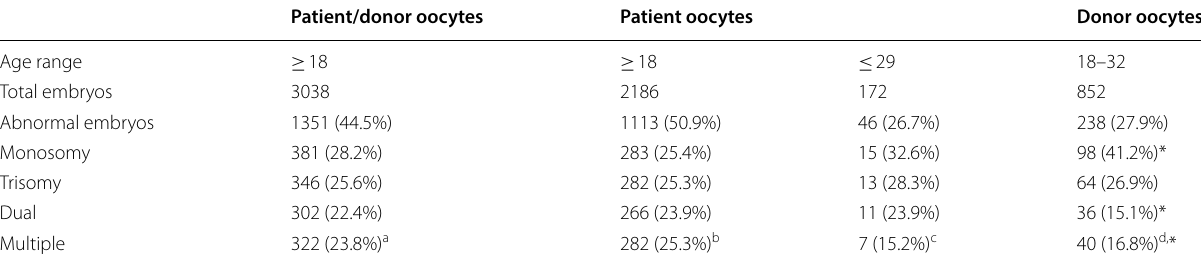
Table 2 Distribution of types of